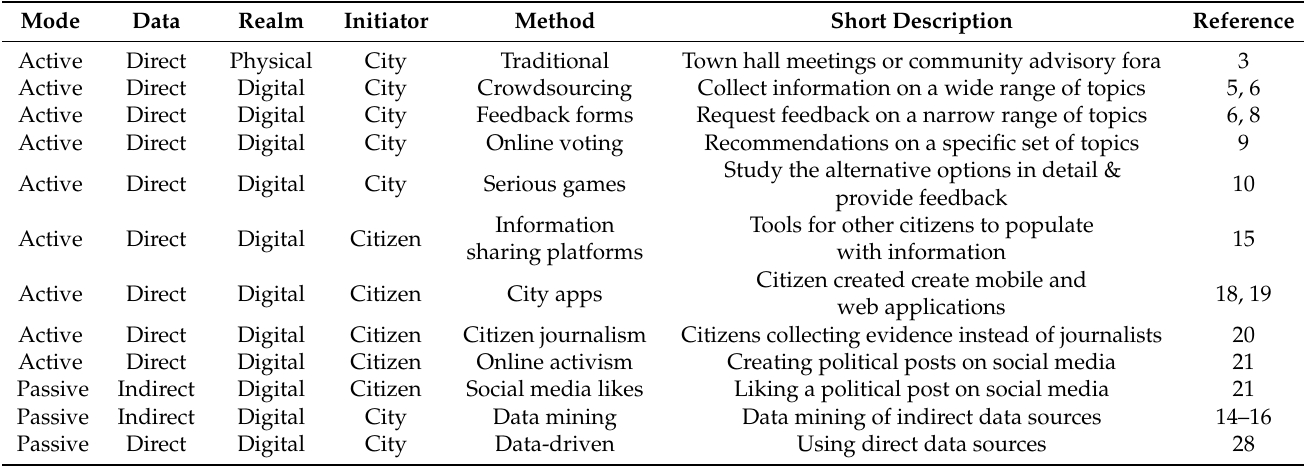
Table 1. The dimensions of public participation methods in the context of the smart